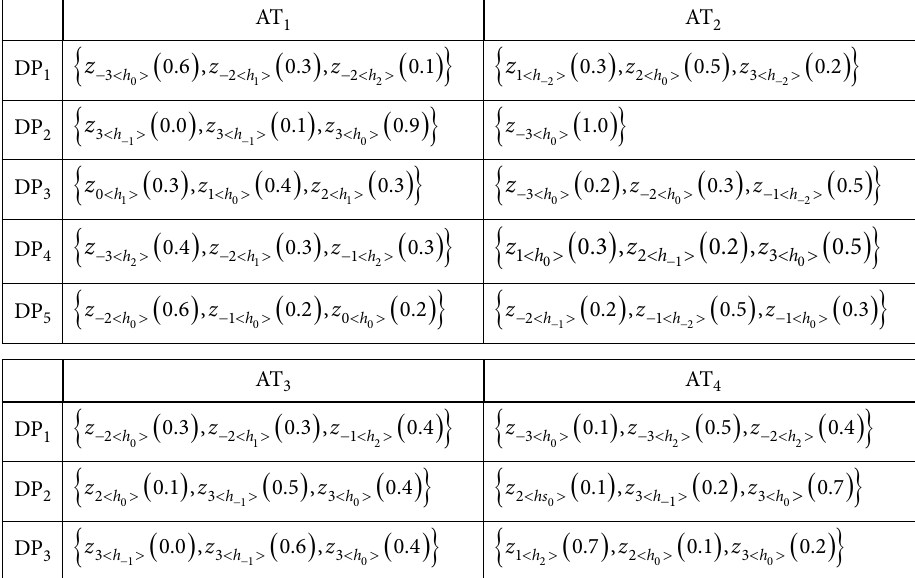
Table 1. The PDHLTSs evaluation of all alternatives is provided by e 1 AT 1 AT